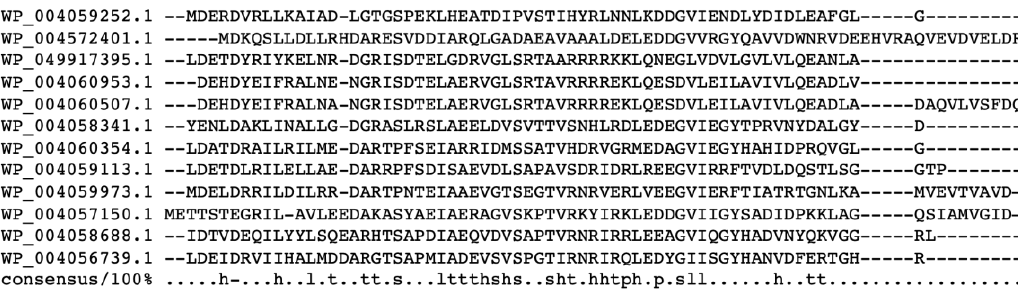
Figure 2. Clustal alignment with Mview of the HTH domain sequences from Hfx. mediterranei . Screenshot of multiple sequences alignment generated by ClustalO and viewed using Mview option. h: hydrophobic; l: aliphatic; t: turnlike; s: small; p: polar.